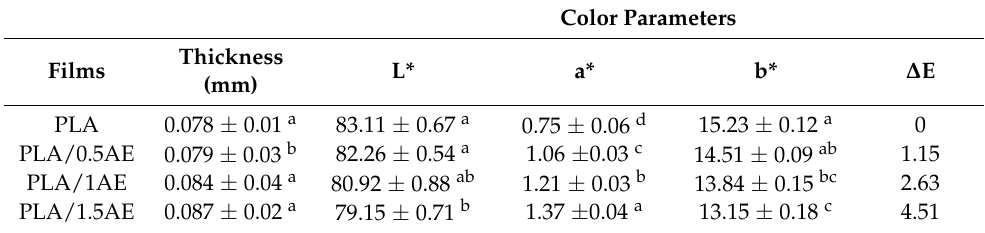
Table 2. Physical properties of poly lactic acid (PLA) films incorporated with anise essential oil (AE) 1 . Color